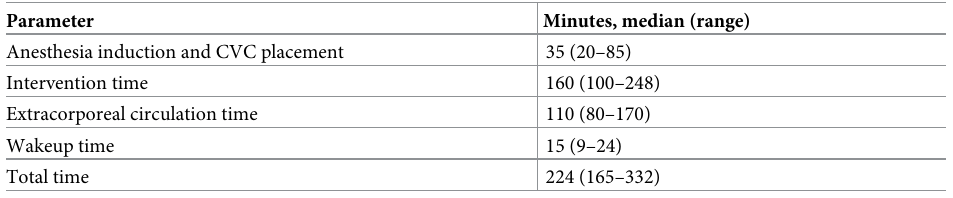
Table 2. Procedure times of percutaneous hepatic melphalan